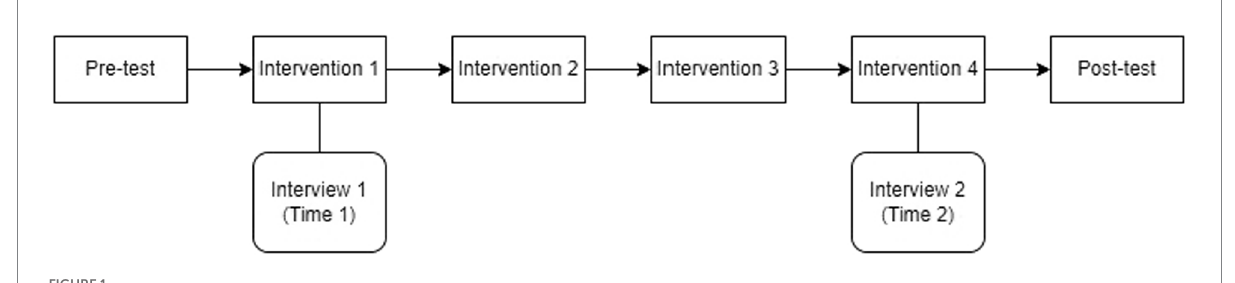
FIGURE 1 Data collection procedures of the experiment.